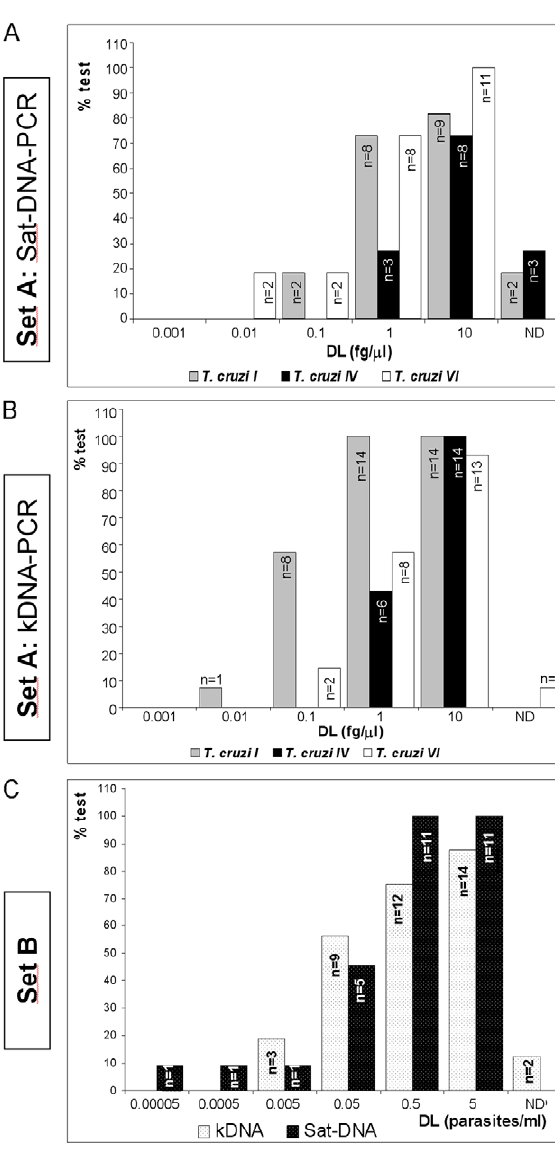
Figure 1. Analytical Sensitivity of specific and coherent PCR tests in sets A and B. Distribution of detection limits (DL) of specific and coherent PCR tests targeted to Sat-DNA (A) and kDNA sequences (B) for detecting serial dilutions of purified DNA from 3 parasite stocks (Set A) representative of T. cruzi DTU I (Silvio 6 10), DTU IV (Can III cl1) and DTU VI (Cl Brener). C. Distribution of detection limits (DL) of specific and coherent PCR tests targeted to Sat-DNA (black bars) and kDNA sequences (white bars) carried out from human blood spiked with serial dilutions of parasite cells (Set B).